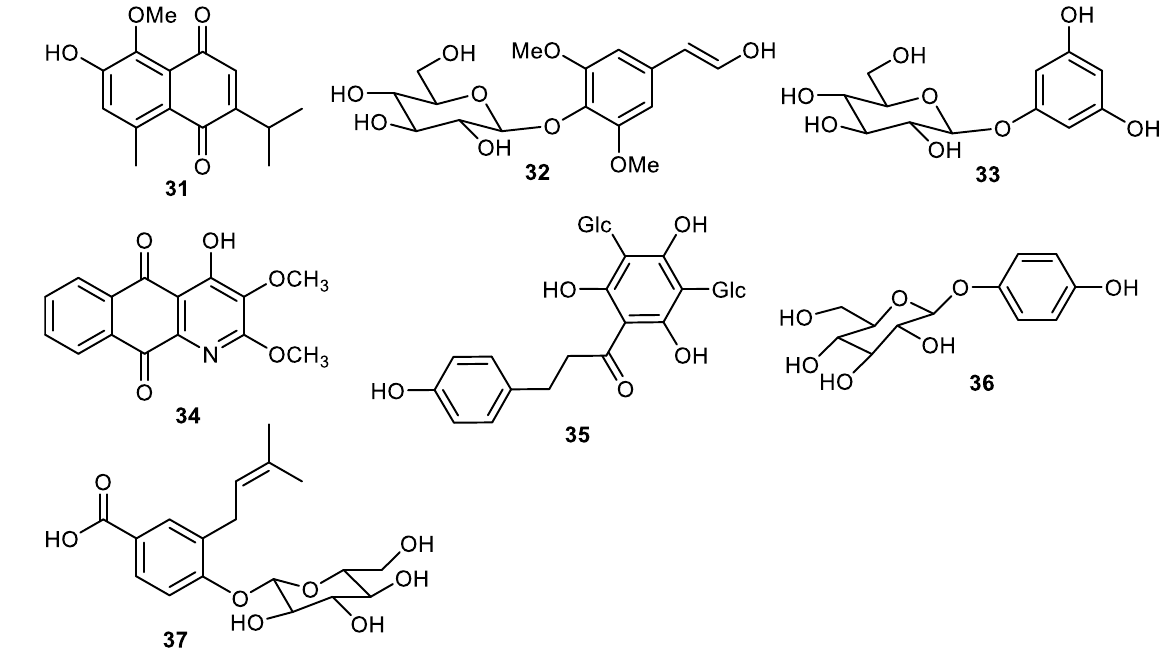
Figure 4. Structures of quinone and phenolic glycosides 31 – 38 .